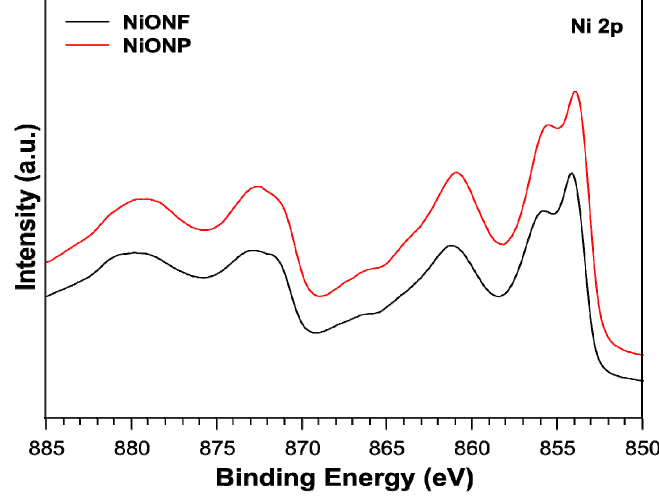
Figure 4. X-ray photoelectron spectroscopy (XPS) Ni 2p spectra for NiO nanofibers and nanoparticles.